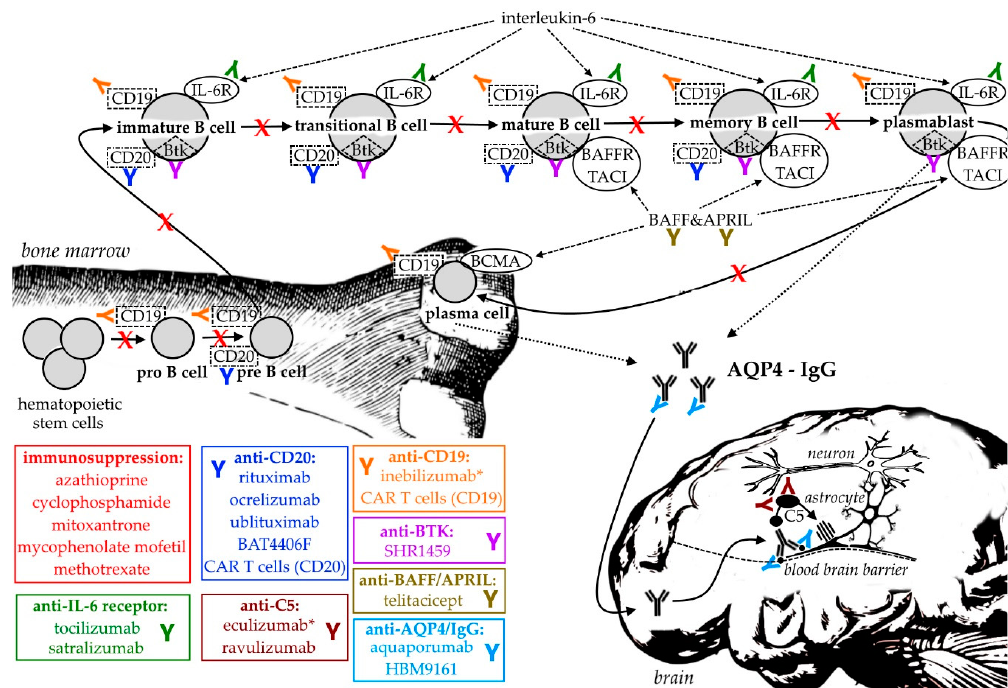
Figure 1. Approved (*) and experimental B cell- and antibody-targeting treatment options in neuromyelitis optica spectrum disorders. B cell development begins in the bone marrow, where hematopoietic stem cells proliferate into pro- and pre-B cells. Immature B cells, the earliest B cell subset in the peripheral blood undergo maturation into transitional, mature and memory B cells upon stimuli like interlukin-6 (IL-6), B cell activating factor (BAFF) and A proliferation-inducing ligand (APRIL). Plasmablasts and plasma cells are capable of producing immunoglobulins, including pathological anti-aquaporin-4 (AQP4) immunoglobulin G (IgG). After binding AQP4 on astrocytic foot processes at the blood-brain barrier, complement activation (including complement factor 5(C5)) causes cytotoxicity by forming membrane attack complexes with subsequent neuronal injury. BAFFR = BAFF receptor; BCMA = B cell maturation antigen; BTK = Bruton’s tyrosine kinase; CAR = chimeric antigen receptors; CD = cluster of differentiation; IL-6R = interleukin-6 receptor; TACI = transmembrane activator and calcium-modulator and cyclophilin-ligand